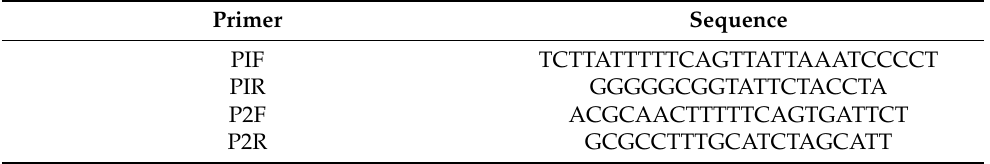
Table 4. PCR primers used in PCR